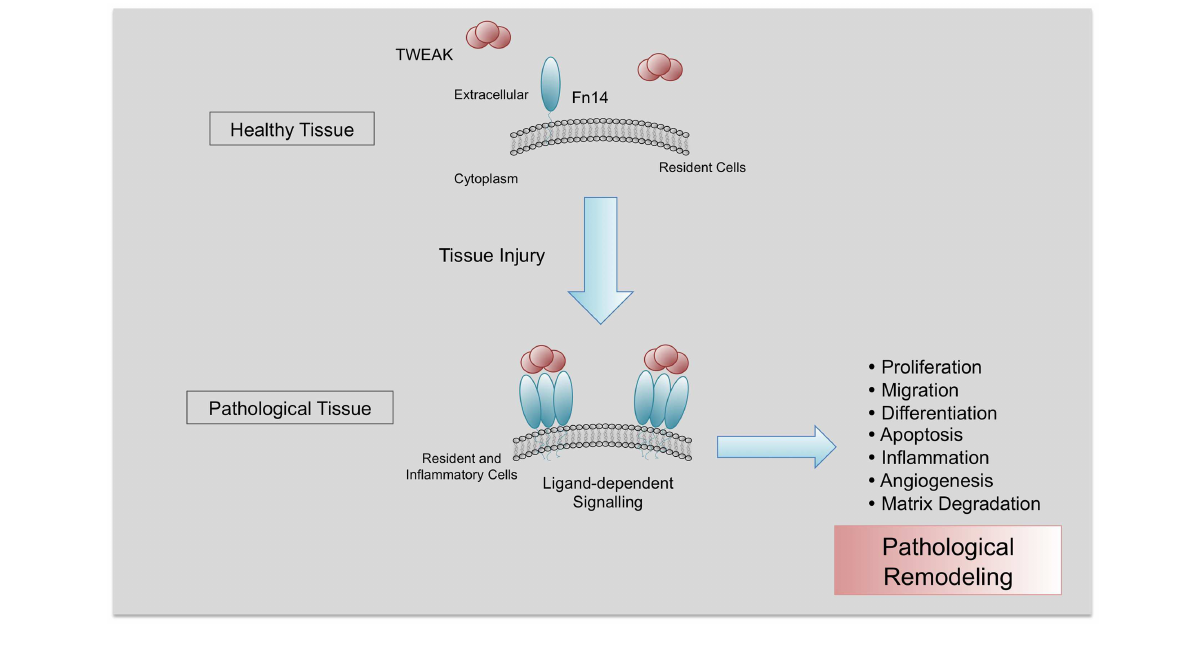
FIGURE 2 | Pathological actions ofTWEAK/Fn14 interaction . Fn14 is almost absent in healthy tissues. After injury, Fn14 is upregulated, facilitating the interaction with its ligandTWEAK and its trimerization. In a context of